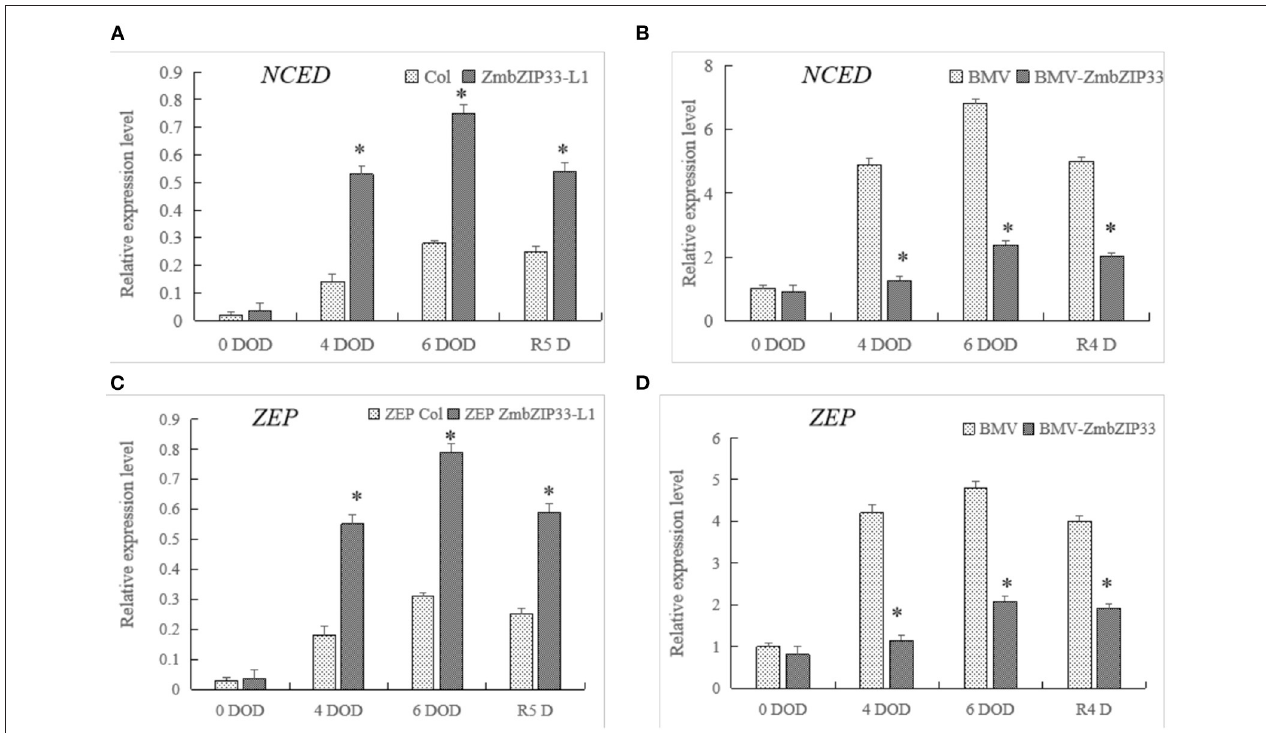
FIGURE 9 | The expression of genes related to ABA synthesis in ZmbZIP33 transgenic line and control under drought stress and rewatering. (A,B) NCED-9-cis-epoxycarotenoid dioxygenase . (C,D) ZEP-Zeaxanthin epoxidase . Mean values and standard errors (bar) were shown from five independent experiments. Independent t -tests for equality of means demonstrated that there was significant difference between control and treatment (* P value <